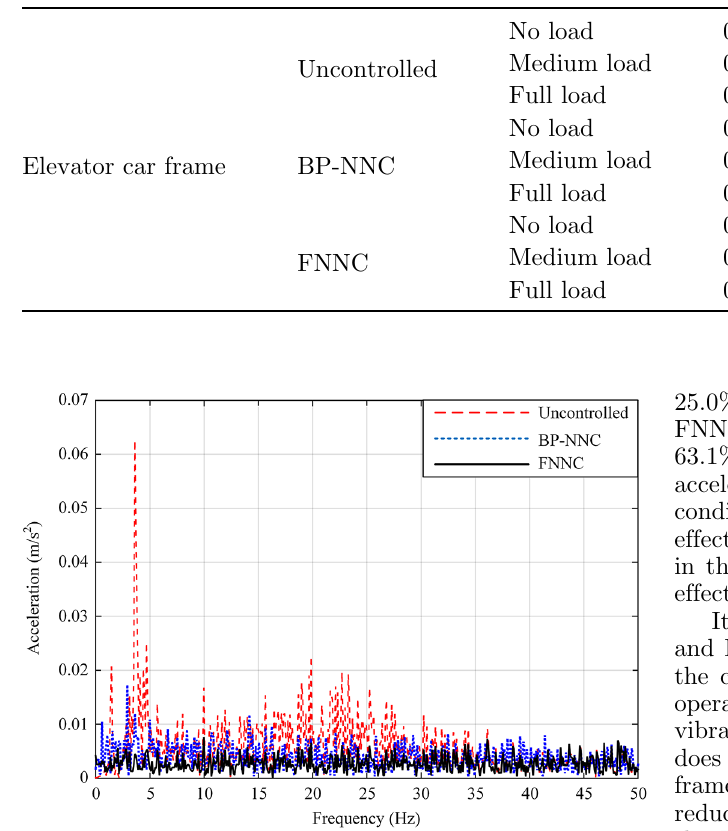
Fig. 30. Frequency-domain response of horizontal vibration acceleration of the elevator car frame with a full load.